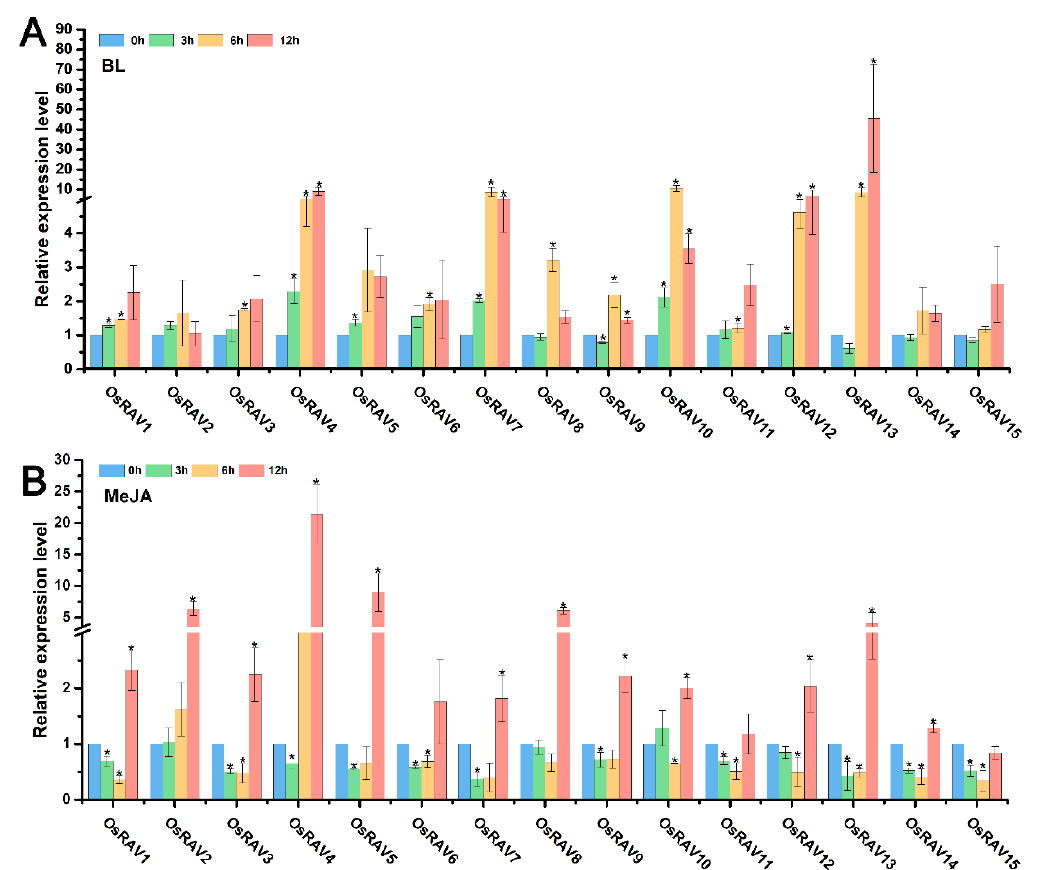
Figure 6. Relative expression level of fifteen RAV genes following hormone treatments. Plants were treated with BL (10 µ M) ( A ), MeJA (100 µ M) ( B ) and sampled at 0, 3, 6, and 12 h. qPCR data were normalized using OsUBQ5 . Results are the means ± standard deviation (SD) of three biological replicates. * indicates significant difference from the mock control at p ≤ 0.05 by Fisher’s least significant difference tests.